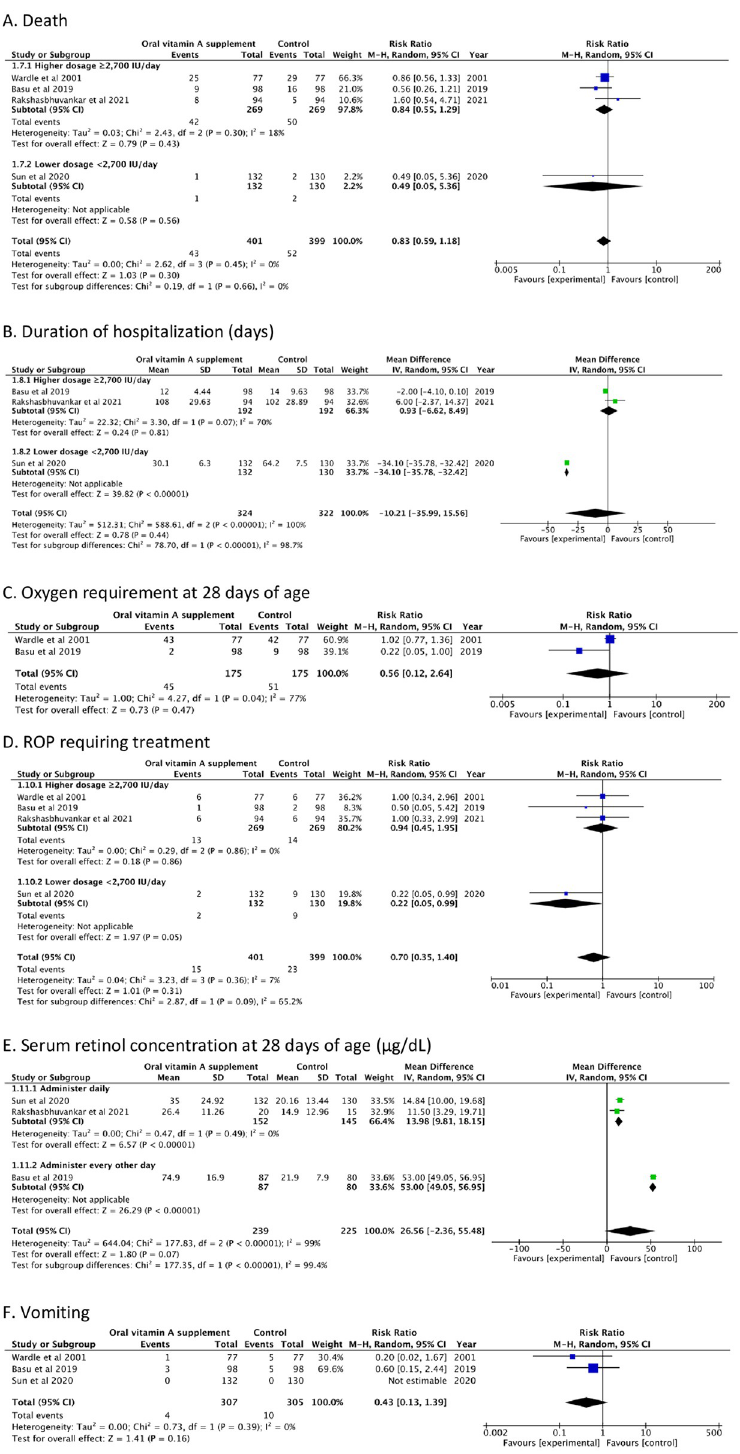
Fig 3. Forest plots of the effects of oral vitamin A supplementation in preterm infants and adverse effects. (A) Death; (B) Duration of hospitalization (days); (C) Oxygen requirement at 28 days of age; (D) ROP requiring treatment; (E) Serum retinol concentration at 28 days of age ( μ g/dL); (F) Vomiting.